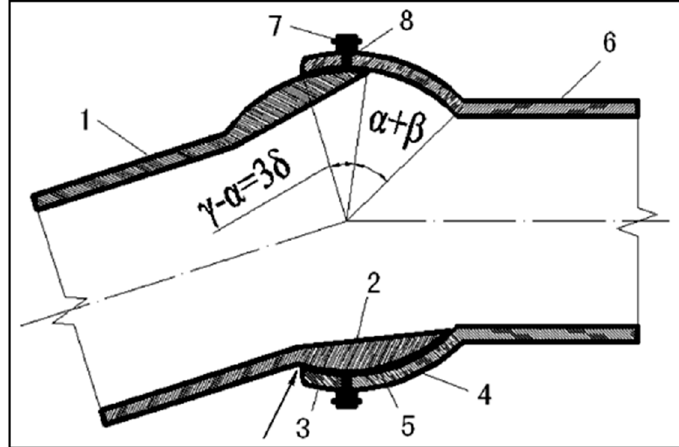
Figure A2. Scheme of the joint for pipelines, patent CN102588689A. Ball Joint